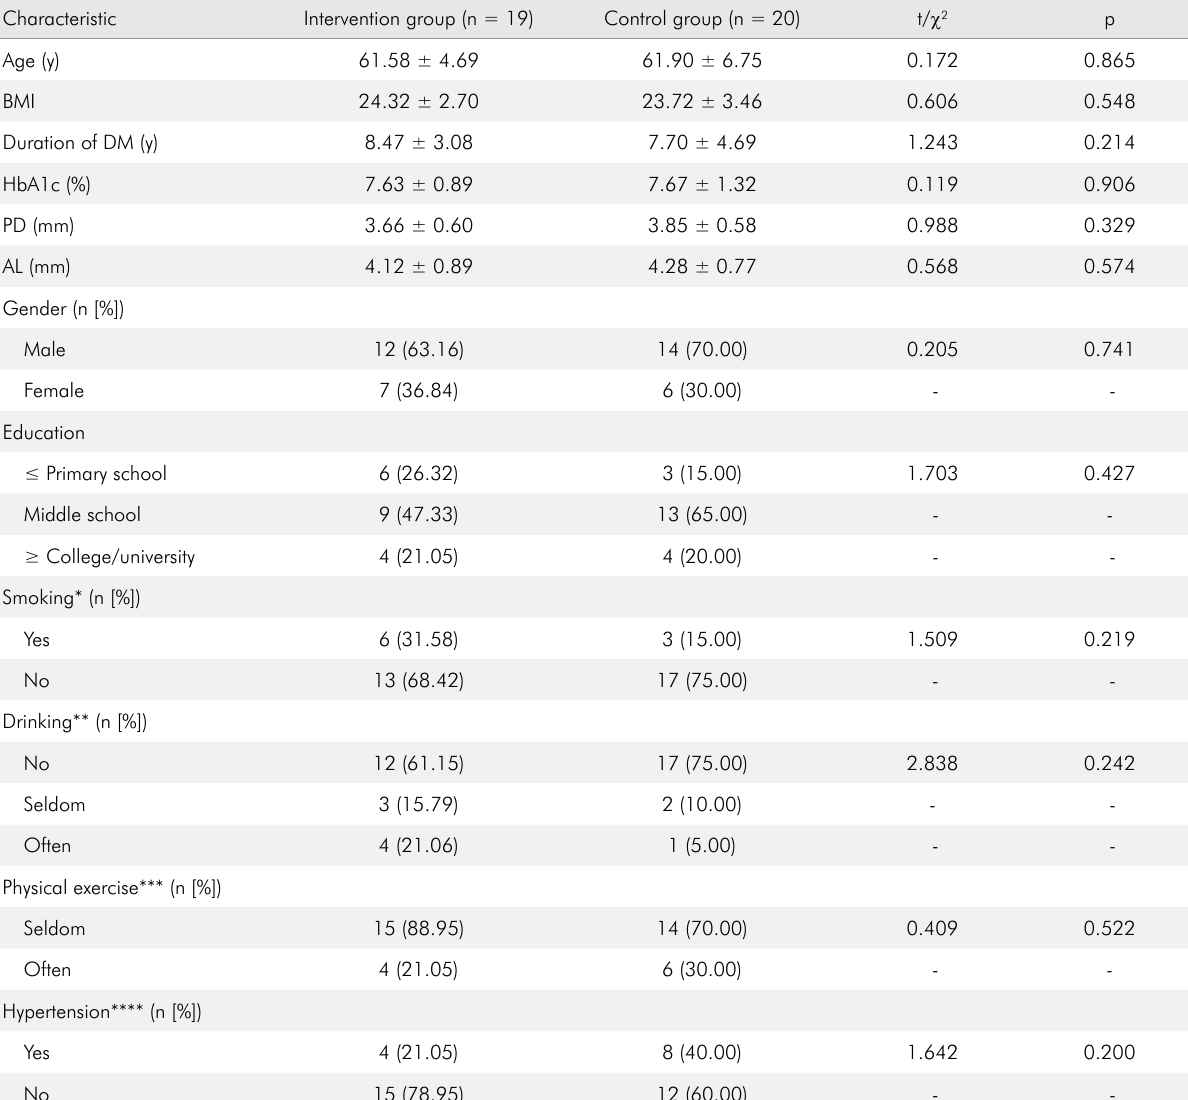
Table 1. Demographic characteristics of the study groups at baseline.